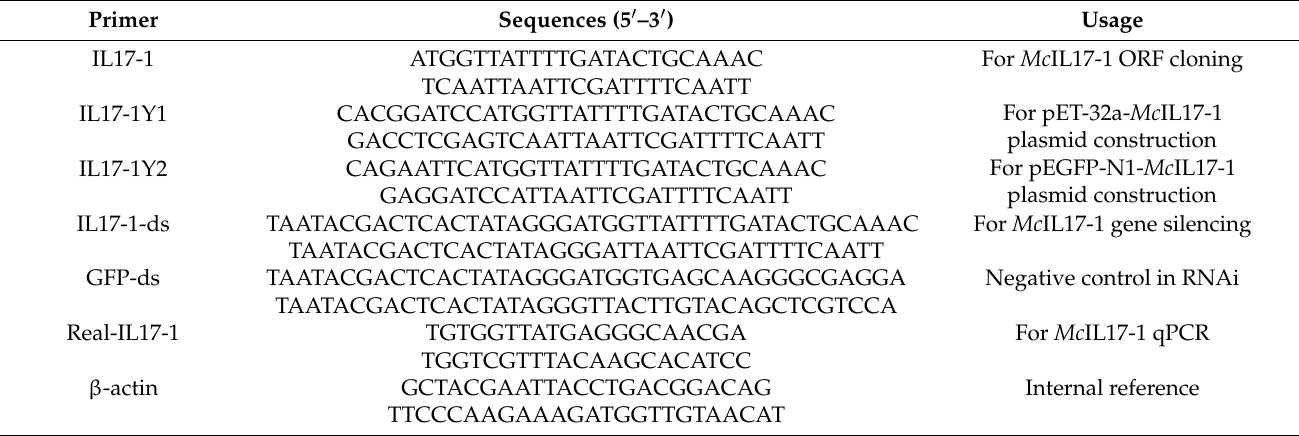
Table 1. PCR primer pairs used in the present